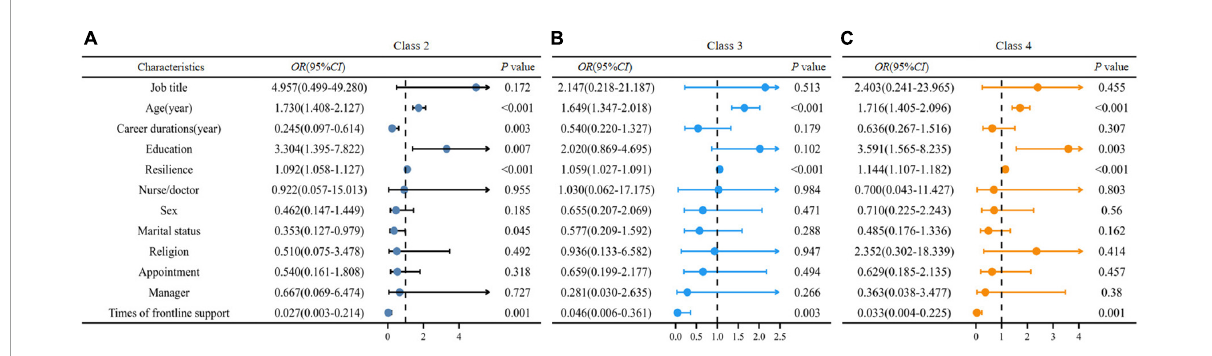
FIGURE3 Forest map of multivariate logistic regression. Association of baseline variables with trajectory class assignment ( n = 565). OR represents odds of class assignment, compared with reference class of “Persistent low.” CI indicates confidence interval. (A) Compared with Class 1, the OR value of baseline indicators for Class 2. (B) Compared with Class 1, the OR value of baseline indicators for Class 3. (C) Compared with Class 1, the OR value of baseline indicators for Class